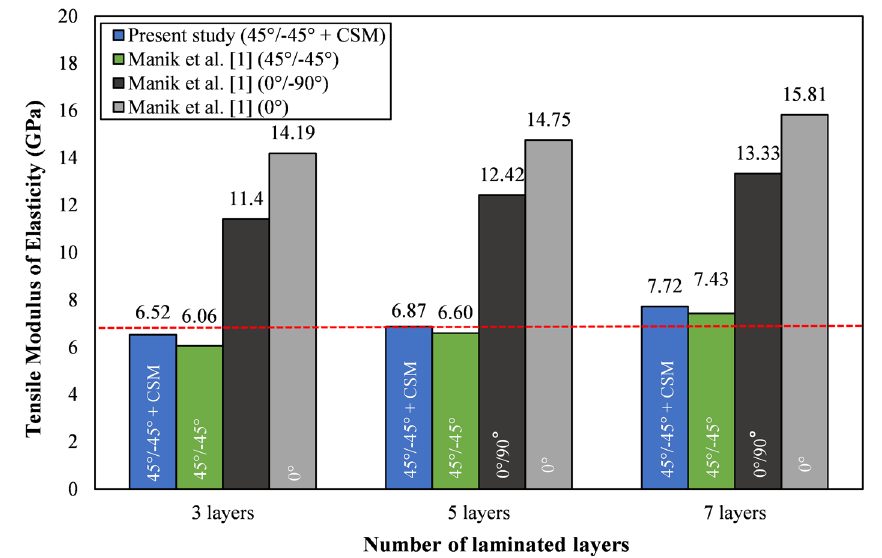
Figure 9: Comparison of MOE results under di ff erent numbers of layers.